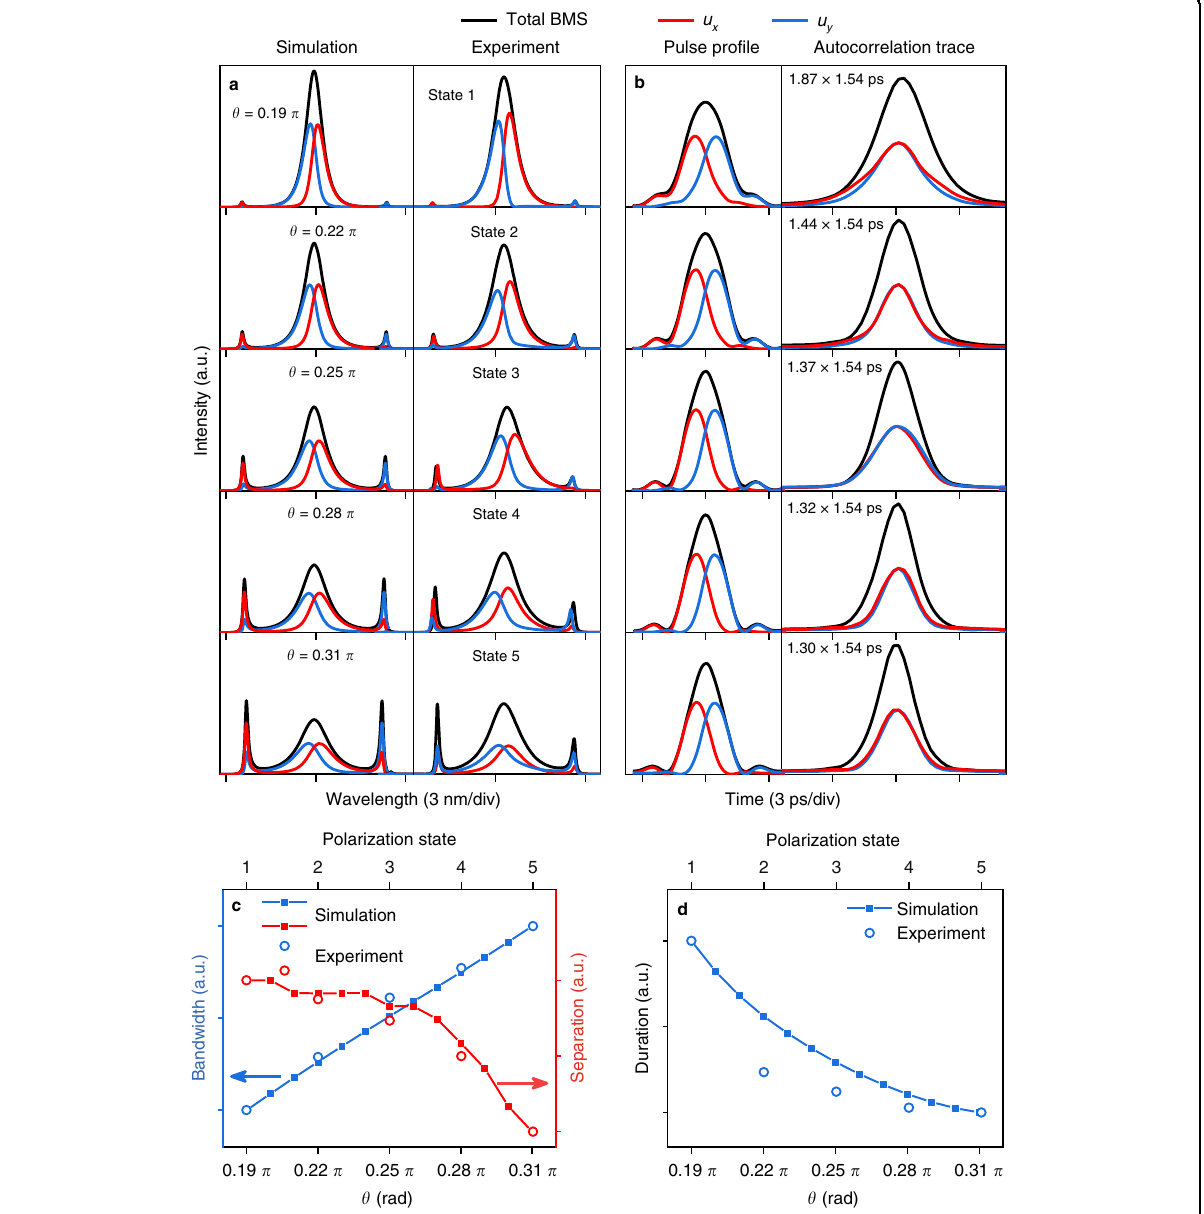
Fig. 3 Evolution of BMS with the polarization orientation θ . a Simulated and measured spectra. b Simulated pulse pro fi les and measured autocorrelation traces. c Bandwidth of BMS and sideband separation of u y component and d pulse duration as a function of θ